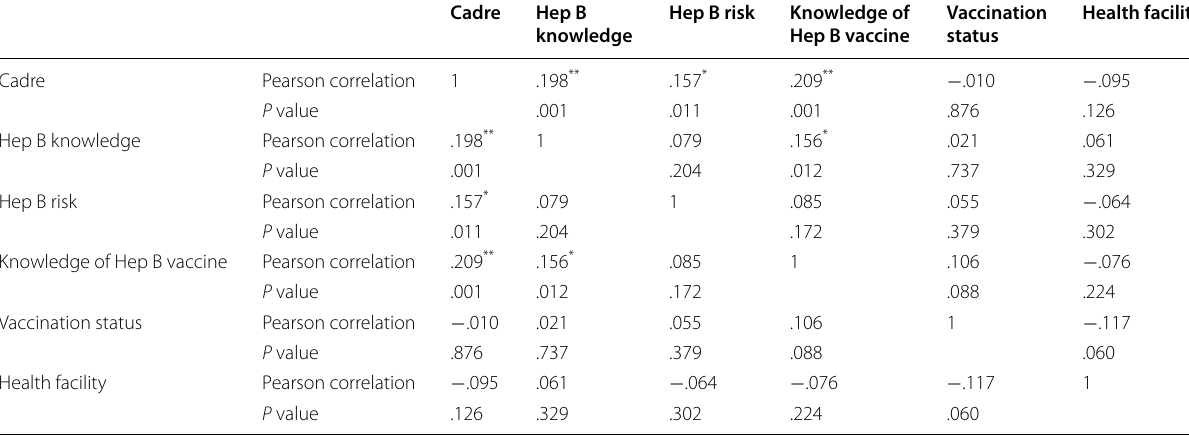
**Correlation is significant at the 0.01 level (2-tailed) *Correlation is significant at the 0.05 level (2-tailed)